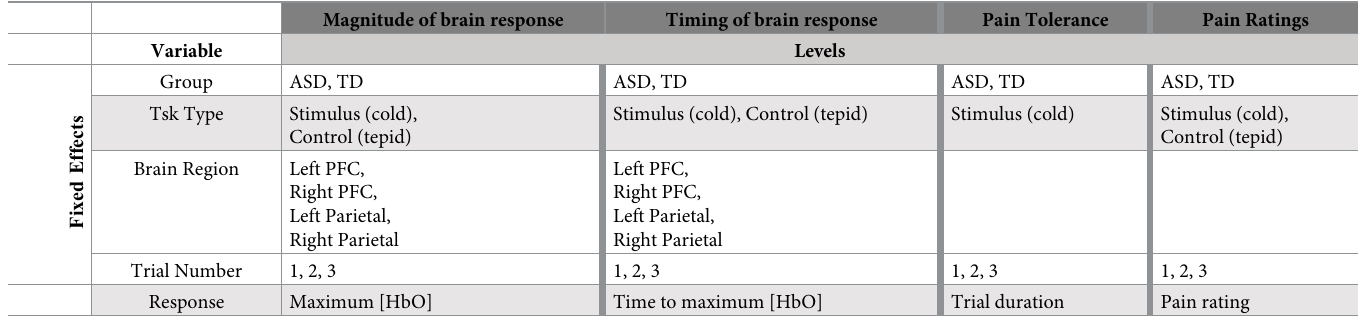
Table 1. Variables considered for statistical analysis of magnitude and timing of functional brain